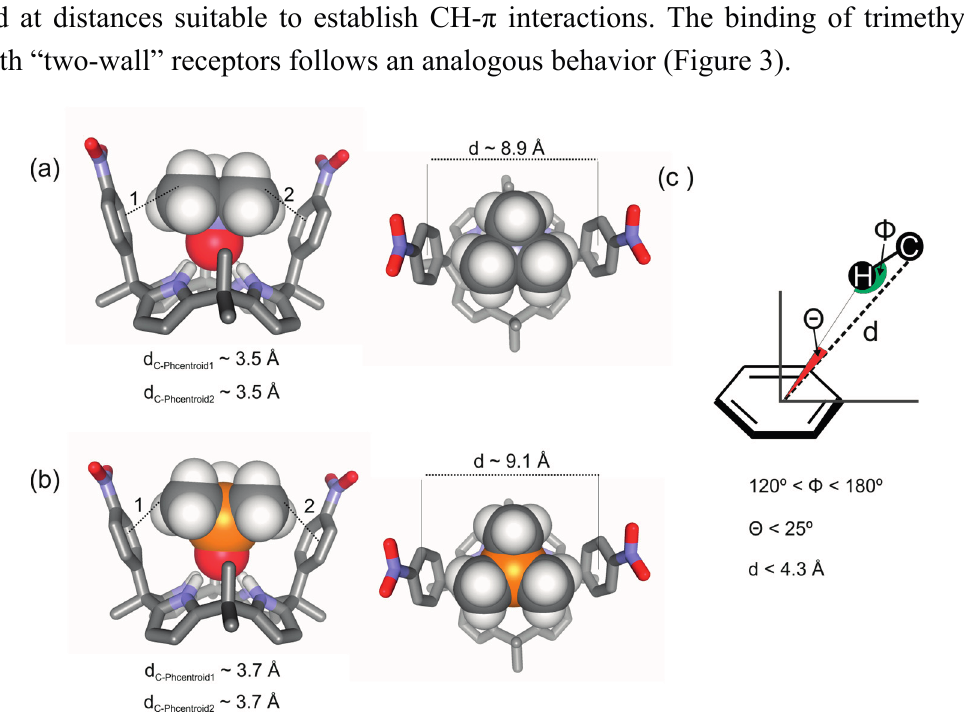
Figure 3. Energy minimized structures for the inclusion complexes of a “two-wall” aryl-extended calix[4]pyrrole with trimethylamine N -oxide 2a ( a ) and with